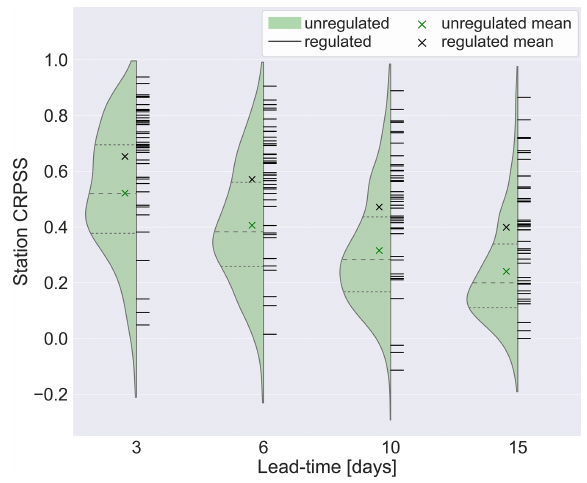
Figure 14. Violin plot of the CPRSS values for the 480 unregulated stations (green distribution) and the 42 regulated catchments (black lines) at lead times of 3, 6, 10, and